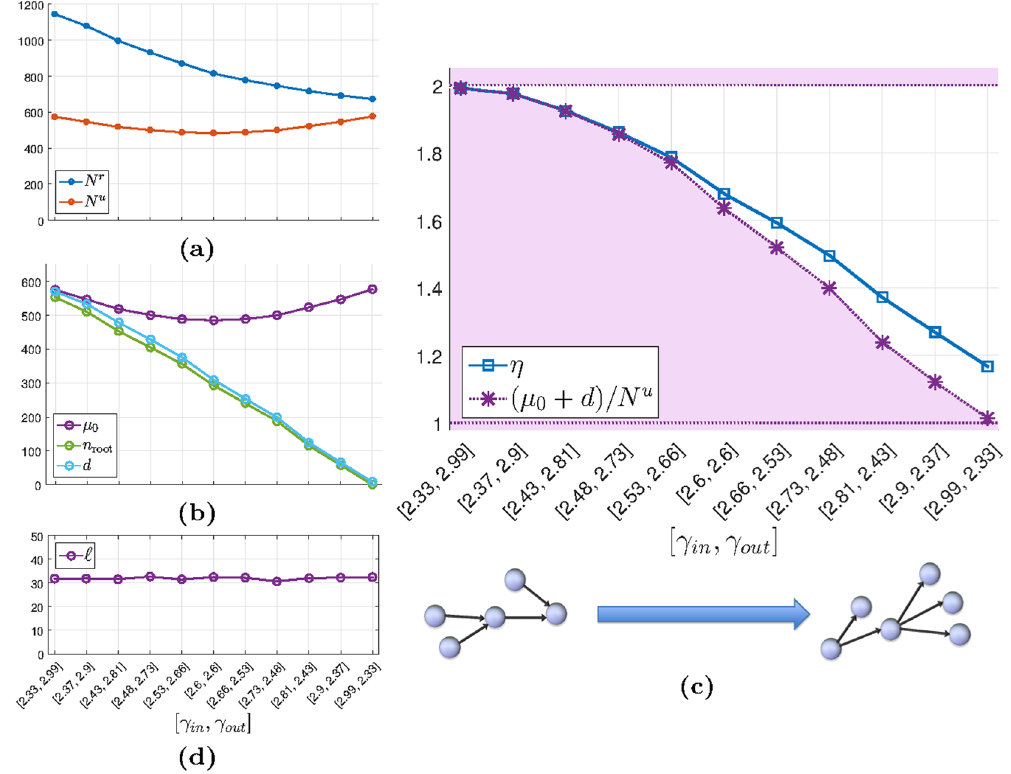
Figure 5. Unilateral controllability of scale-free networks. Networks of size n = 1000 are generated with different indegree and outdegree exponents, γ in and γ out . For each configuration of γ in and γ out , 1000 random networks with edge weights sampled from a normal distribution are generated and the figures show their averaged values. The total number of edges is the same for all configurations. ( a ) N u follows μ 0 (shown in ( b )) and is relatively constant for all configurations while N r drops significantly when the networks are shifted from indegree-dominated to outdegree-dominated. ( b ) μ 0 , n root and d are shown. In the left-end side of the plot   A ( ) is essentially generated by the many roots present in these networks. As the degree exponents are shifted (from left to right of the plot), the roots tend to disappear and instead dilations add to the dimension of   A ( ) . At the right end of the plots  A ( )  is essentially generated by one or a few large dilations, hence d ≪ μ 0 . ( c ) η with its upper and lower bounds are shown. Moving from left to right the lower bound ( μ 0 + d )/ N u decreases and η follows it. The bound is however not achieved, which in part can depend on the heuristics that is used to compute N r . ( d ) The number of real eigenvalues  is fairly constant across degree distributions (the total density of edges is